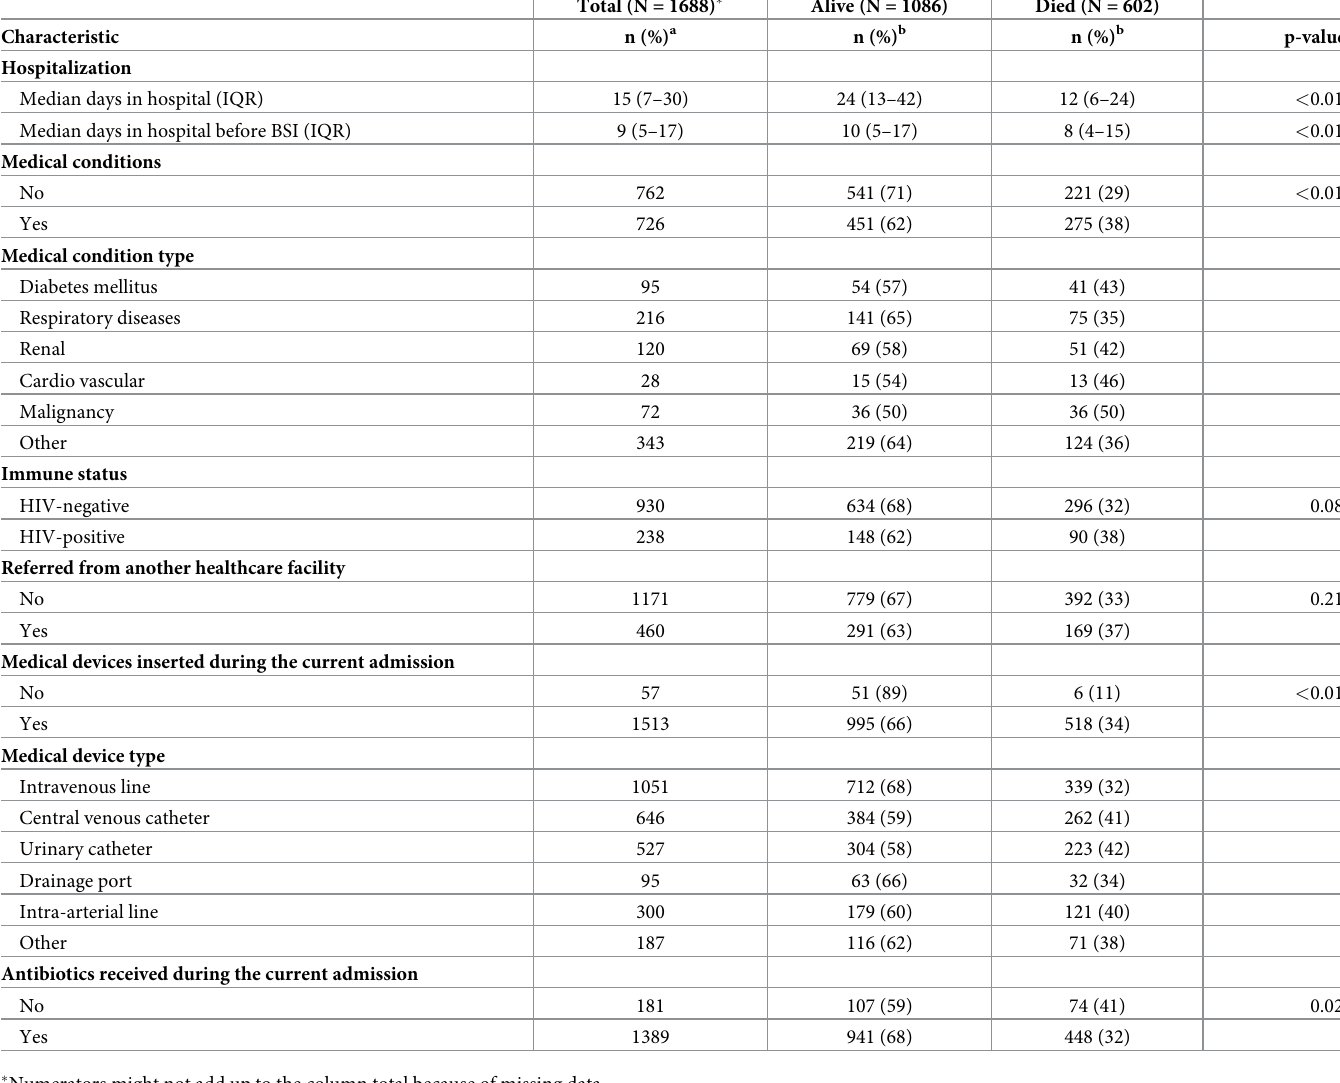
Table 2. Clinical characteristics of Acinetobacter baumannii complex (ABC) cases with known patient outcomes in South Africa, 1 August 2018 to 30 September